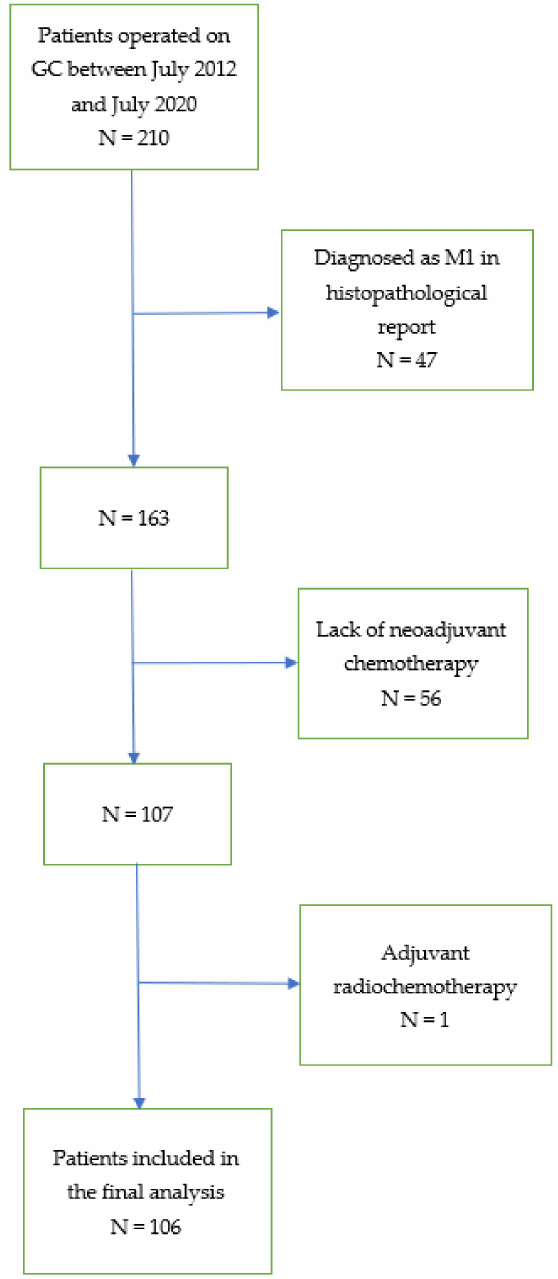
Figure 1. Flow chart of the study. (GC—gastric cancer; M1—distant metastases; N—number of